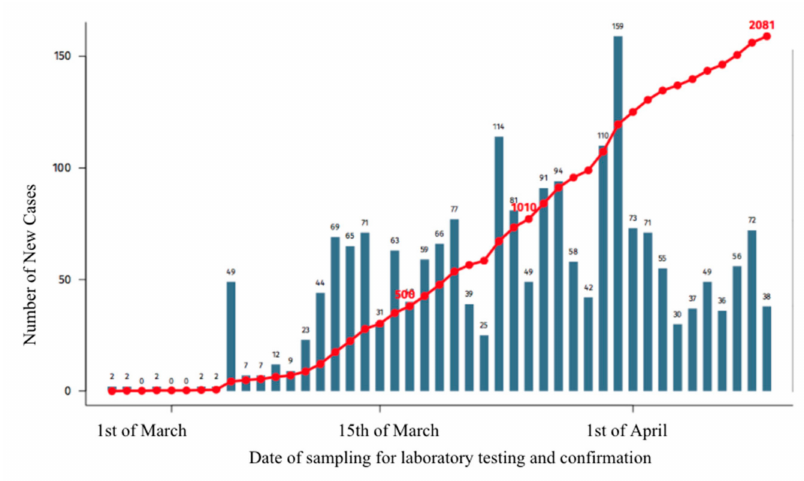
Scheme 2. Confirmed COVID-19 cases in Greece as of the 11 April 2020-(the red line shows the cumulative number of confirmed cases) [27].